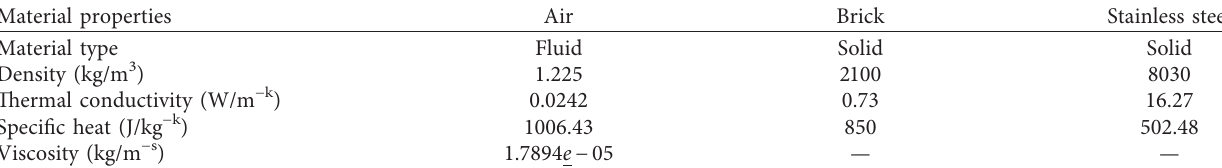
Table 1: Material properties of roaster